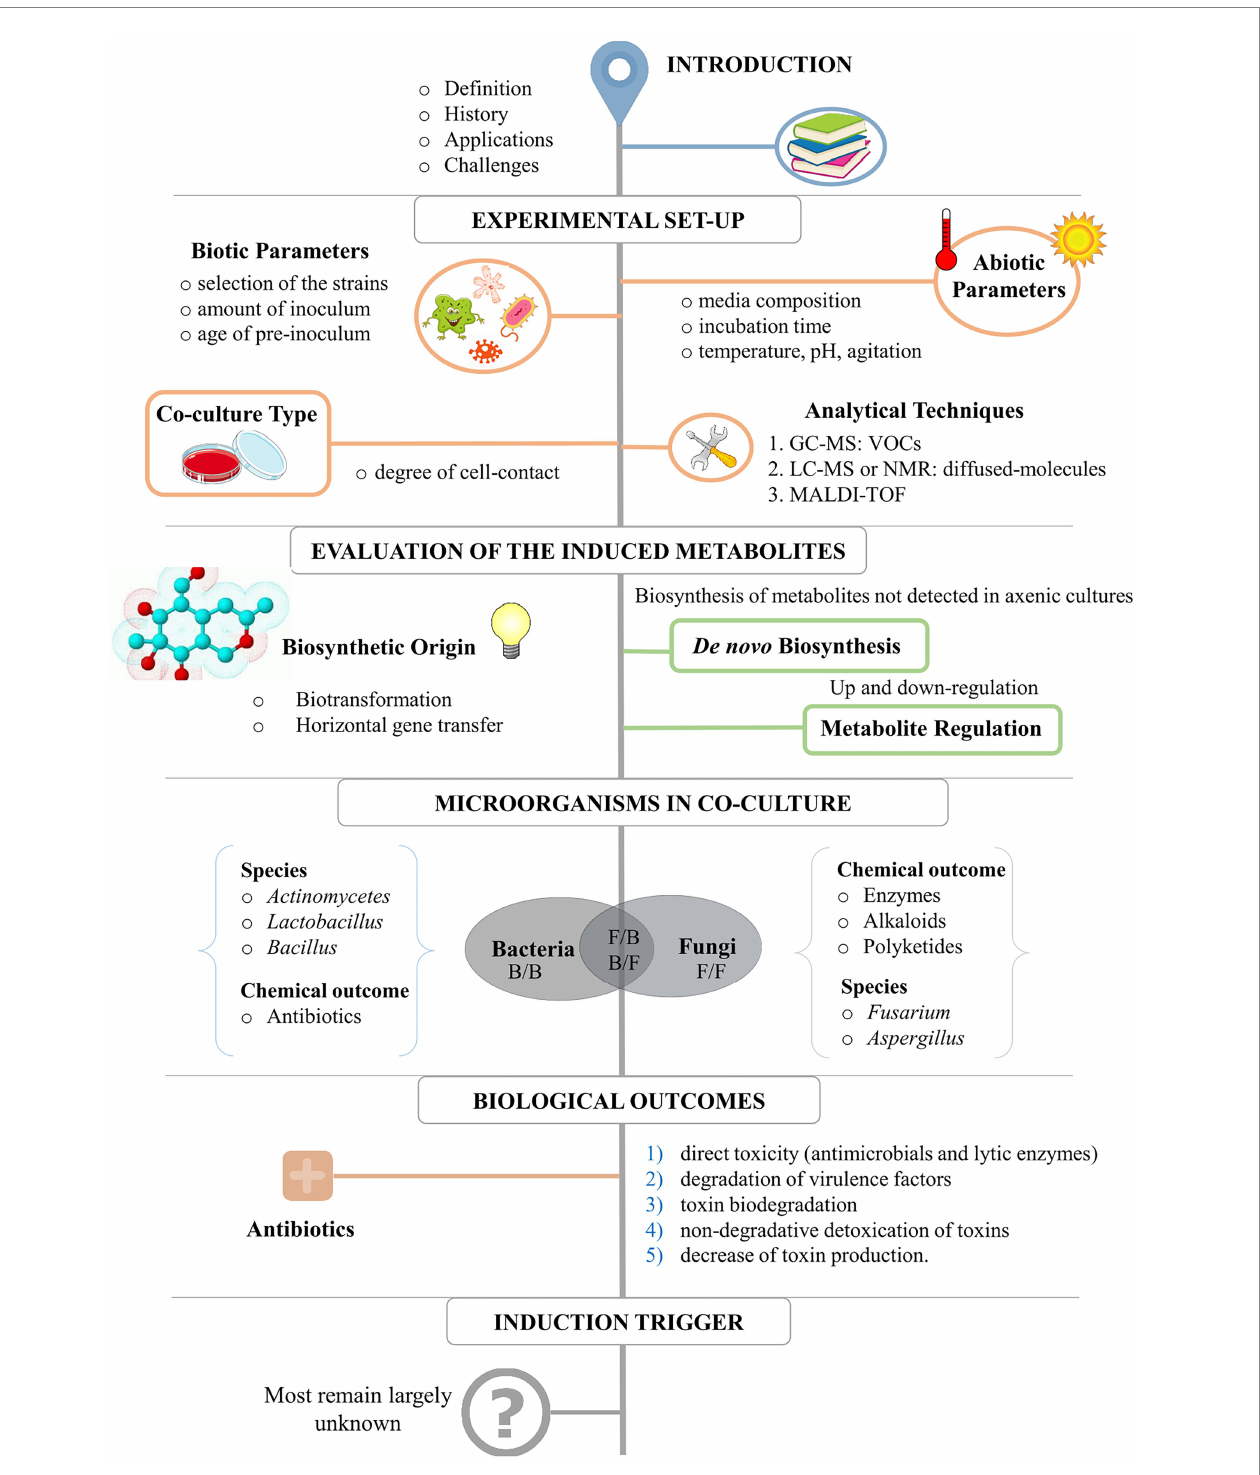
FIGURE 2 Topics for the application of co-culture for the enhancement of chemical